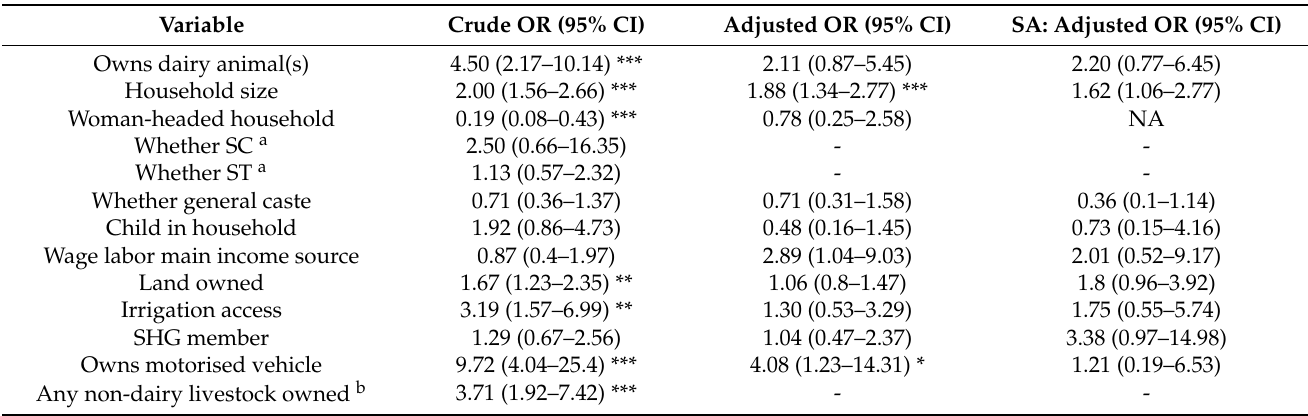
Table 4. Crude and adjusted odds ratios (ORs) and a sensitivity analysis (SA) comparing household milk consumption with the explanatory variables based on data collected between April and July 2019 from four villages in Kolar district,